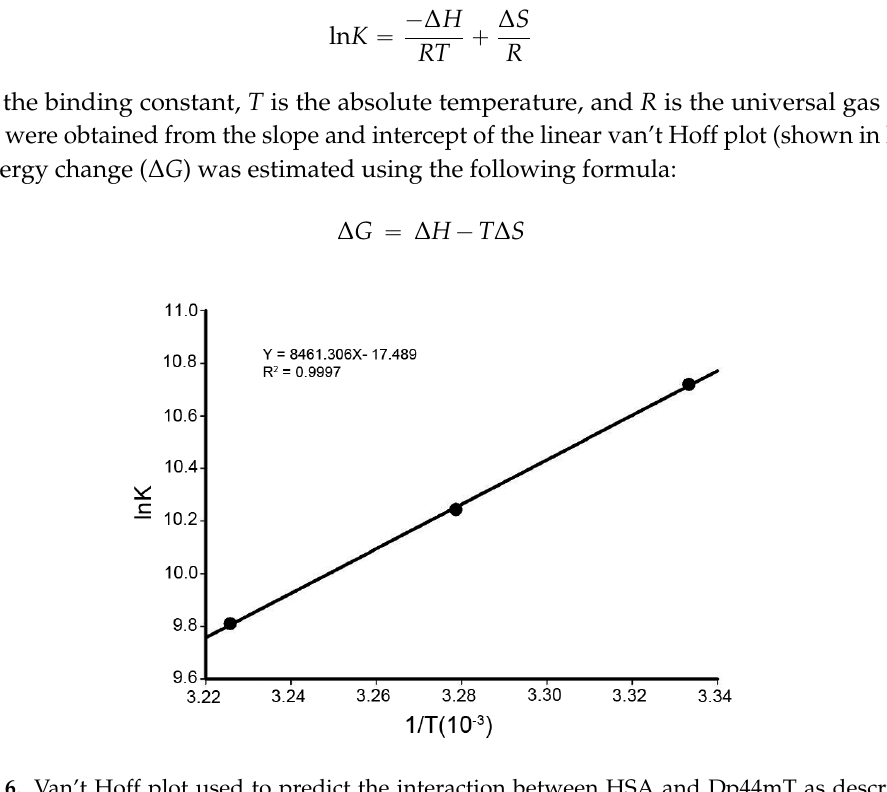
Table 4. Thermodynamic parameters obtained for the Dp44mT-HSA interaction as described [16].